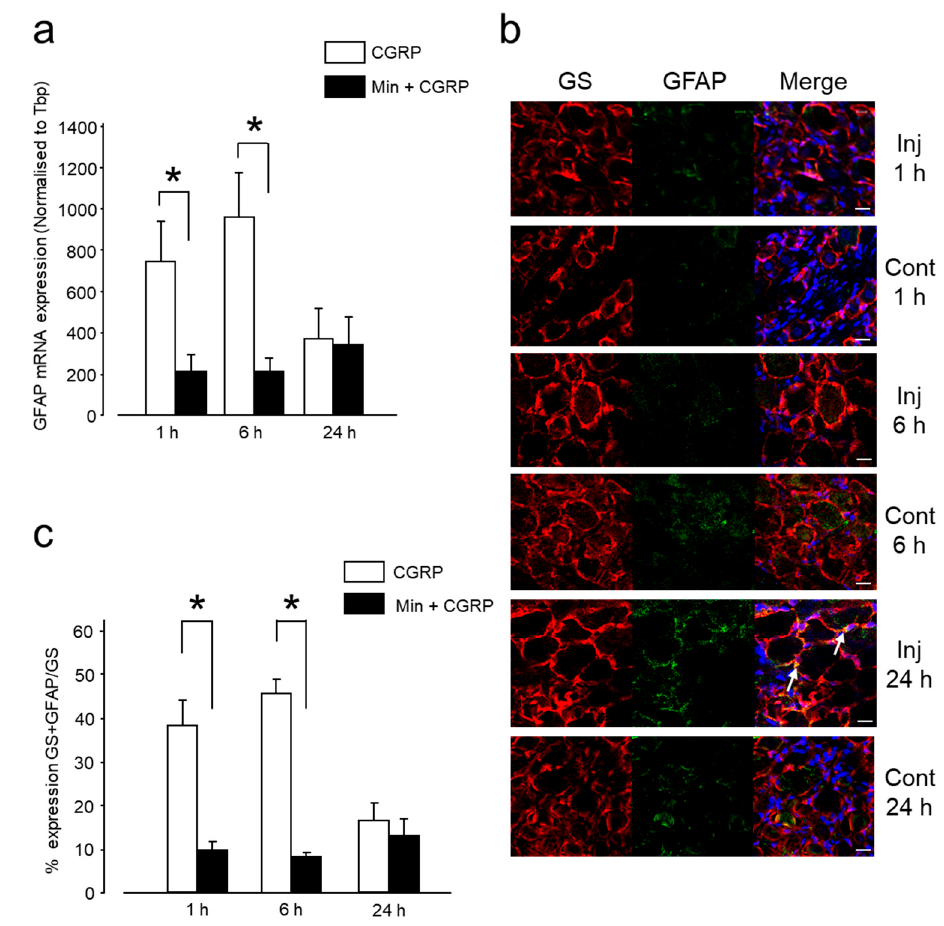
Figure 6. Effect of injecting Min 1 h before CGRP on glial inhibition. ( a ) mRNA expression of GFAP in TG was significantly decreased 1 and 6 h after administration in the Min + CGRP group compared to CGRP alone group. Results are presented as Mean ± SEM of relative expression. *: p < 0.05 with t -test. n = 5 rats were assigned to each group. ( b ) Confocal images of immunofluorescent staining of TG sections with GS (red), GFAP (green), and DAPI (blue) after 1, 6 and 24 h of IG Min + CGRP administration and contralateral TG. Colocalization of GS and GFAP in the SGCs is denoted by white arrow. Scale bar: 20 µ m. ( c ) IG Min 1 h before CGRP administration decreased the GFAP protein expression compared to only CGRP injection at 1 and 6 h. *: p < 0.05 with t test. n = 3 rats were assigned to each group and data were acquired from three independent sections (i.e., examined in three non-overlapping views).